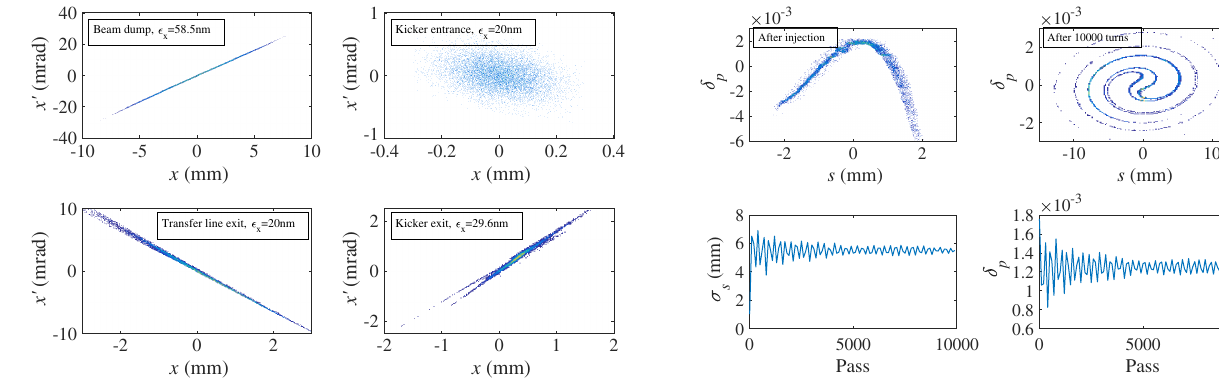
FIG. 14. Longitudinal phase space evolution. Beam reaches pseudomatched state after 10 000 turns.